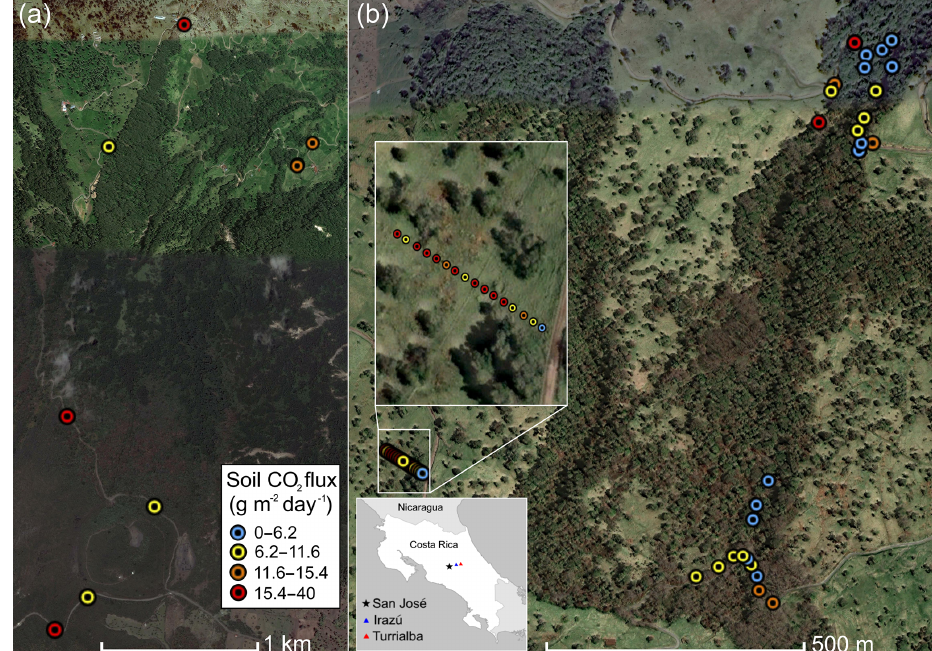
Figure 1. Overview of measurement locations in two old-growth forests on the upper flanks of two active volcanoes in Costa Rica, Turrialba and Irazú. Distribution of mean soil CO 2 flux across north flank of Irazú (a) and south flank of Turrialba (b) . Colors of dots correspond to flux populations (see Fig.